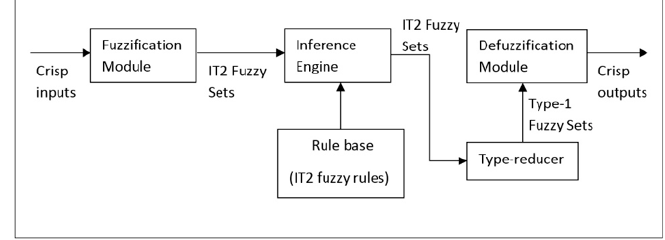
Figure 2. Information flow in a type-2 fuzzy system.